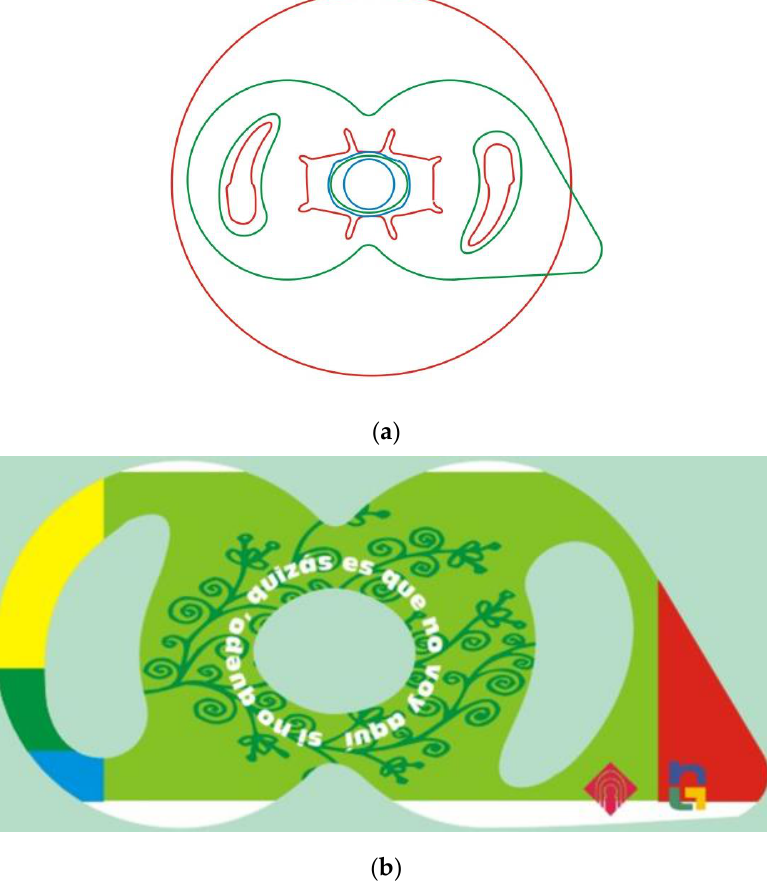
Figure 3. Sticker to be placed on 3-litre containers ( a ) Design; ( b ) Final sticker.